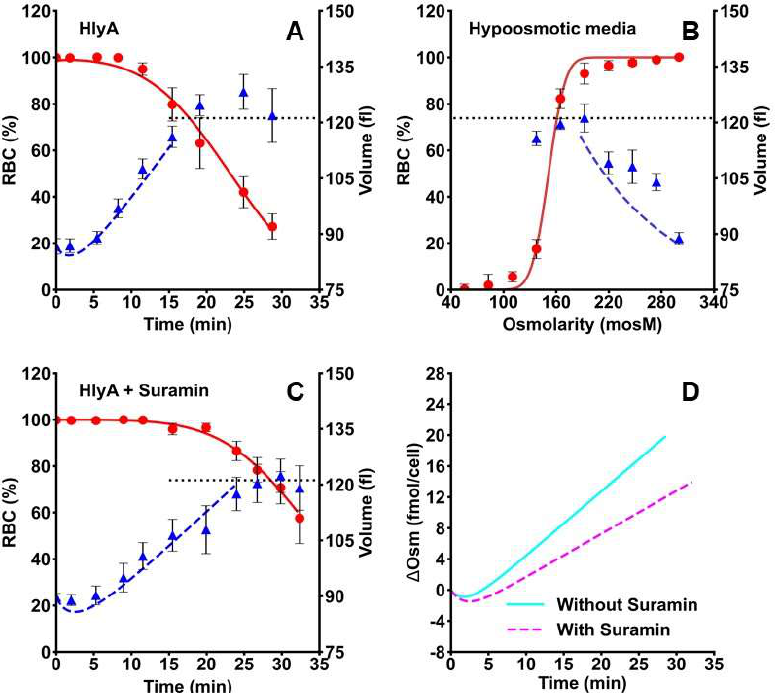
Figure 8. Effects of external osmolarity or HlyA on cell volume and hemolysis of RBCs. RBCs suspensions at 5% hematocrit were employed for experiments. Panel ( A ). Kinetics of MCV (blue triangles) and hemolysis (red circles) in the presence of 40 ng/mL of HlyA. Hemolysis was measured by the release of hemoglobin (as indicated in Section 4.6.1) and expressed as the proportion (RBC %) of viable RBCs. Volume was measured by electrical impedance cytometry (as indicated in Section 4.9) (N = 4). Panel ( B ). MCV (blue triangles) and hemolysis (red circles) as a function of media osmolarity (N = 3–6). Panel ( C ). Kinetics of MCV (blue triangles) and hemolysis (red circles) in the presence of 40 ng/mL HlyA plus 100 µM suramin. The black horizontal dotted line represents the MCV max achieved in hypo-osmolar media. Values are means ± S.E.M. (N = 3–5). In panels ( A , C ), the dashed and continuous lines represent the predicted values of MCV and hemolysis respectively, obtained by fitting model 2 to experimental data (see Section 2.7). The dashed and continuous line in panel B represents the predicted values of MCV and hemolysis, respectively, obtained by fitting model 1 to experimental data (see Section 2.7). Panel ( D ). the plot shows the traces that represent values of ΔOsm vs. time predicted by model 2. The traces were obtained by fitting model 2 to data in Figure 8A,C.